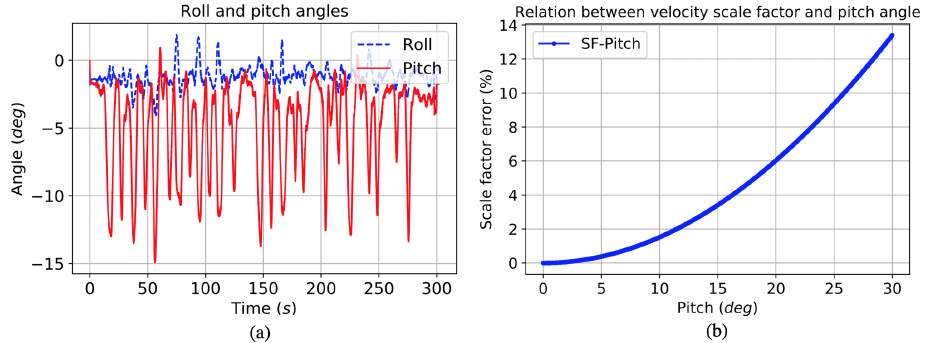
Figure 6. ( a ) Horizontal angles and ( b ) theoretical relation between pitch and forward velocity scale factor error.